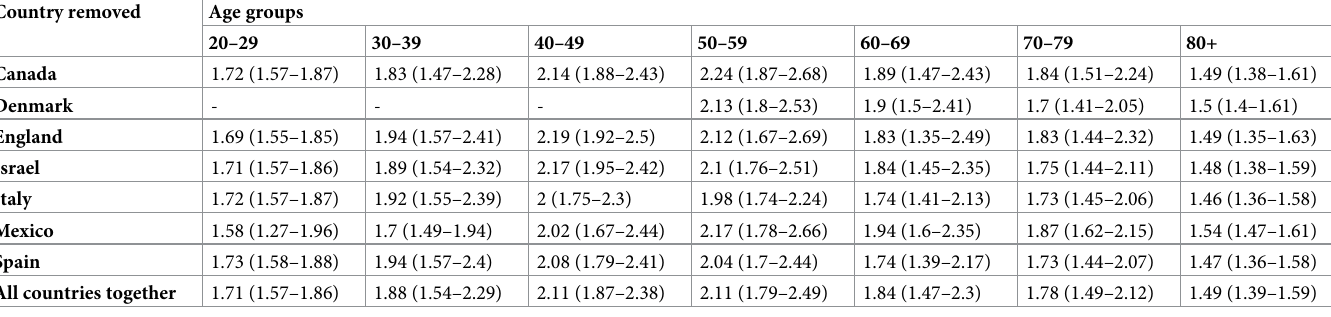
Table 2. Sensitivity analysis of the pooled CFRRs for each age group, by removing one country at a time. Country